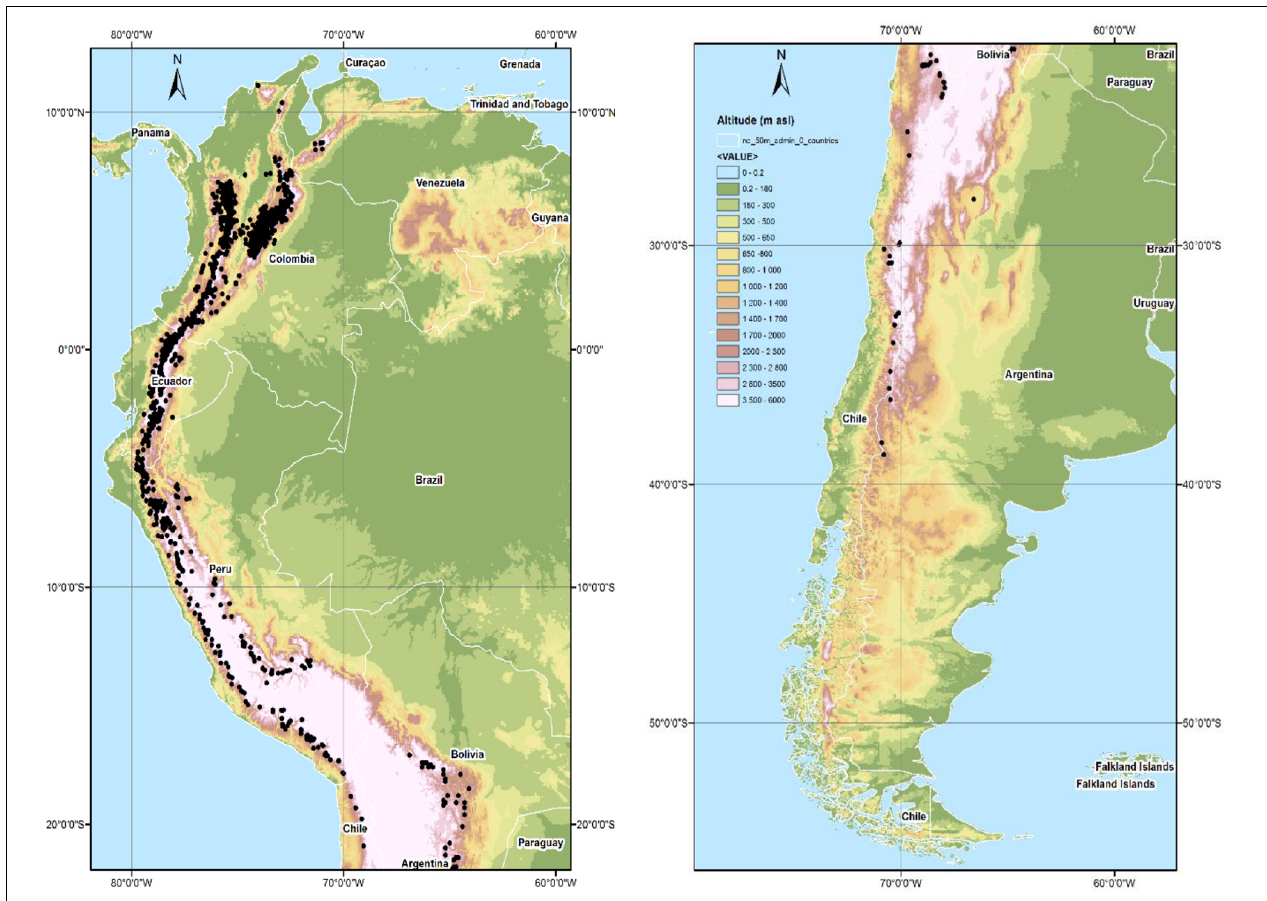
FIGURE 3 | Total of surface stations (meteorological and hydrological) between 2,001 to 3,000 m. Source: National Meteorological and hydrological Services from Bolivia, Chile, Colombia, Ecuador, Peru, Venezuela, and Argentina.